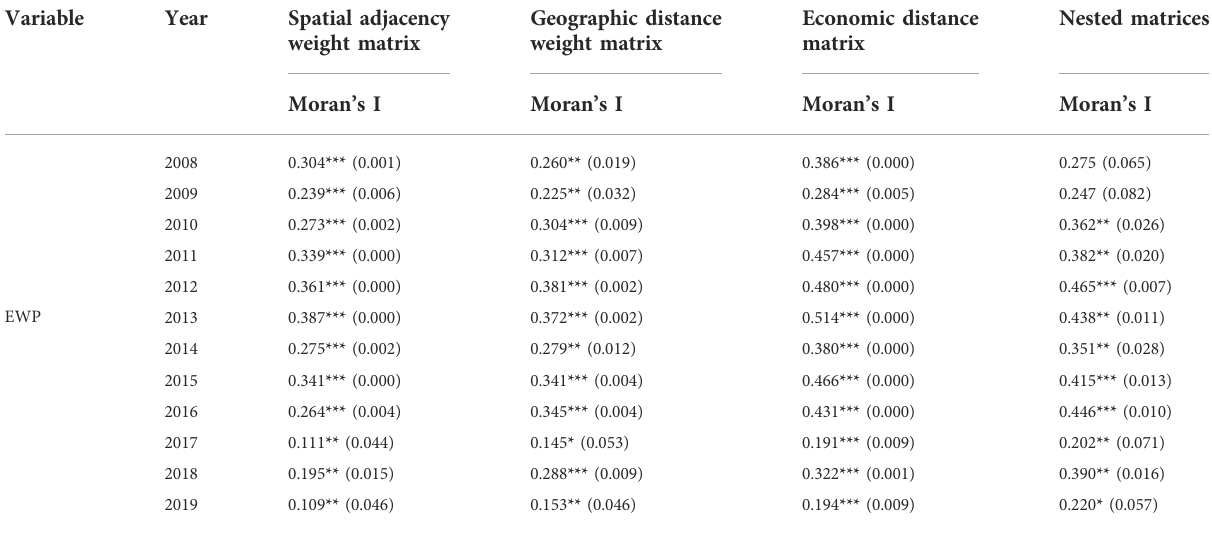
TABLE 4 The Moran ’ s I index of EWP.